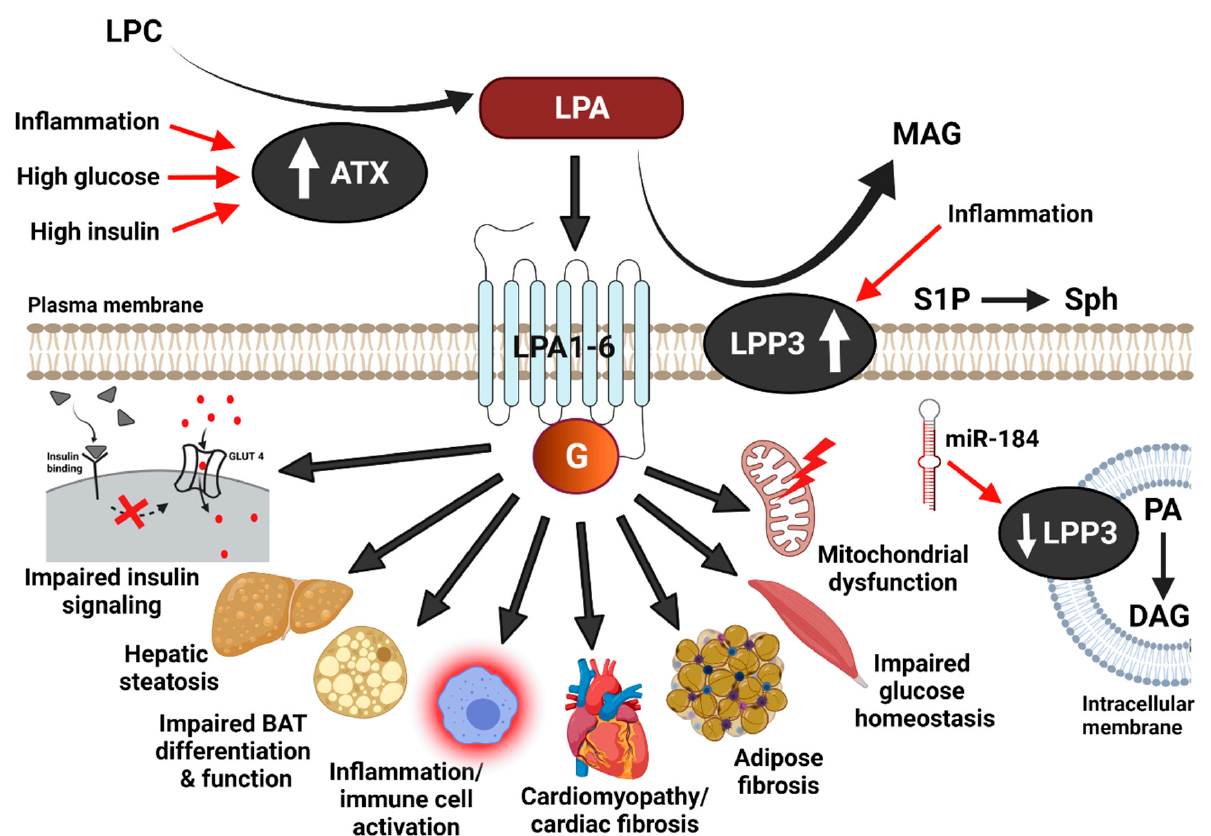
Figure 1. Metabolic effects of the ATX-LPA-LPP3 axis. Autotaxin (ATX) mediated hydrolysis of lysophosphatidylcholine (LPC) produces lysophosphatidic acid (LPA). LPA acts through the G-protein-coupled receptors, LPA1-6, to elicit intracellular signaling. LPP3 dephosphorylates extracellular LPA, thereby generating monoacylglycerol (MAG) and terminating LPA signaling. In addition to LPA, LPP3 can also dephosphorylate other lipids, including sphingosine-1-phosphate (S1P) to sphingosine (Sph) and intracellular phosphatidic acid (PA) to diacylglycerol (DAG). LPA signaling and ATX-LPP3 action have been implicated in metabolic complications in the context of diet-induced obesity. Mechanisms for ATX and LPP3 regulation during obesity and metabolic disease may include high insulin, high glucose, increased inflammation, and miRNA-mediated changes in gene expression. GLUT4, glucose transporter 4.